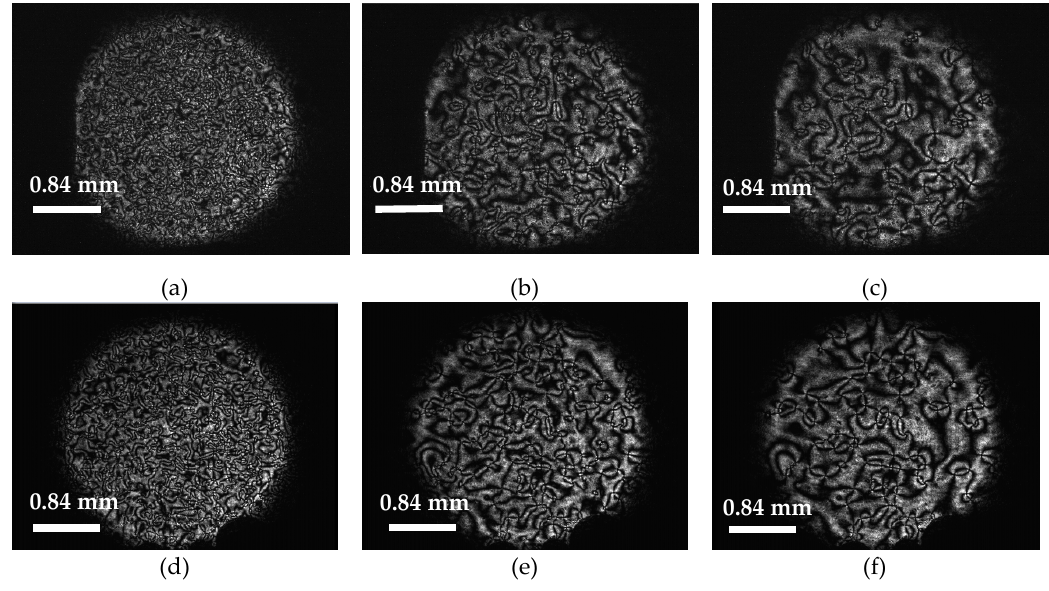
Figure 7. Microphotographs of 2050 LC domains on the DODA biofilm observed under crossed polarizers for input linear horizontal SOP and under voltage of 2.15 V applied to the cell in three time intervals of the samples with thickness of 10 µ m after ( a ) 25 s, ( b ) 150 s ( c ) 300 s and 15 µ m after ( d ) 25 s, ( e ) 150 s, ( f ) 300 s.